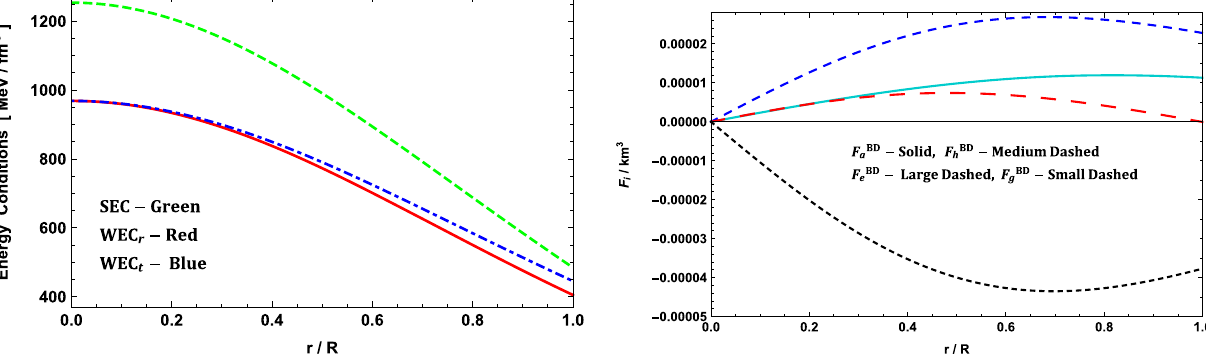
Fig. 4 TheenergyconditionsandTOV-equationareplottedagainst r / R and r respectivelybytakingthesamevaluesasinFig.1forPSRJ1903+327